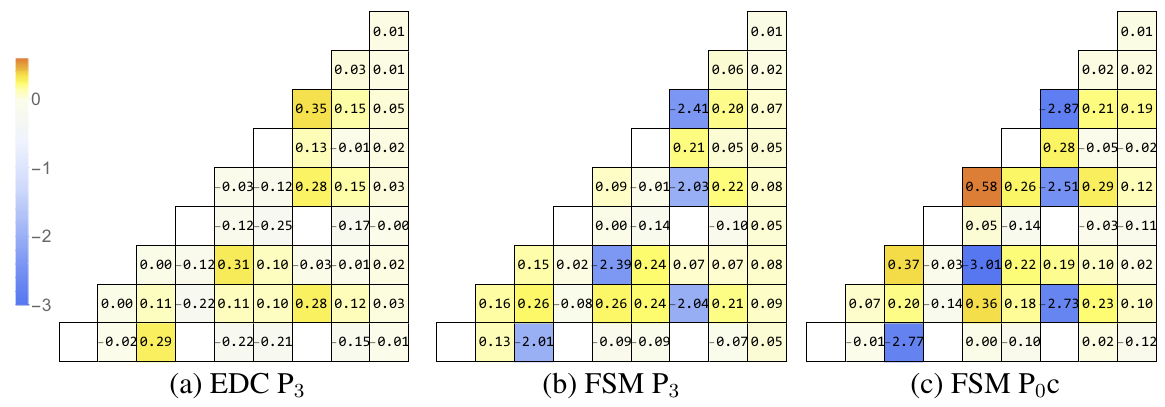
Figure 3: The pin-wise production rate percent errors in the Gd-UOX